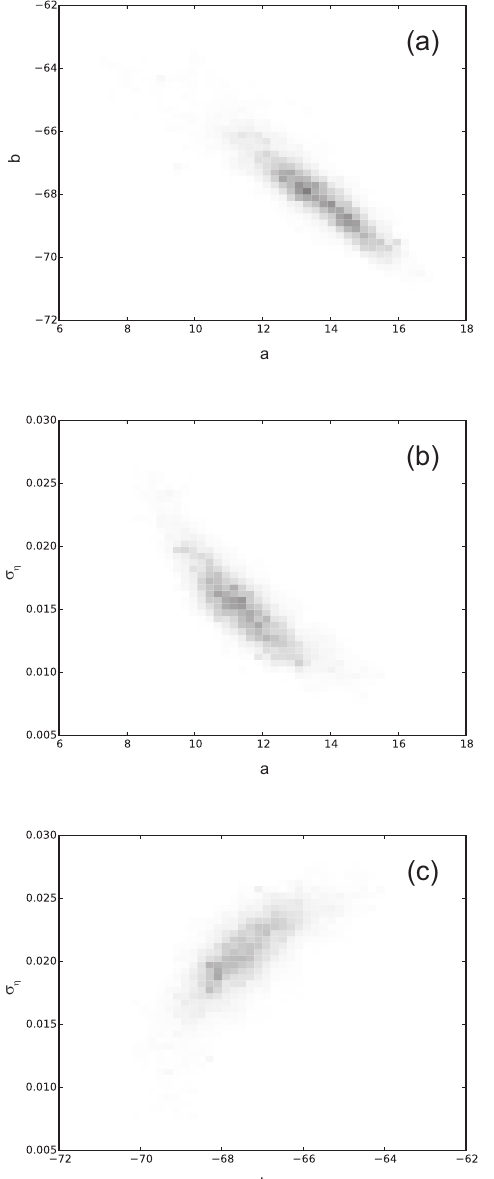
Figure 3. Two-dimensional histograms of the marginal posterior distribution of a and b (a) , the marginal distribution of a and σ η (b) , and the marginal distribution of b and σ η (c) .